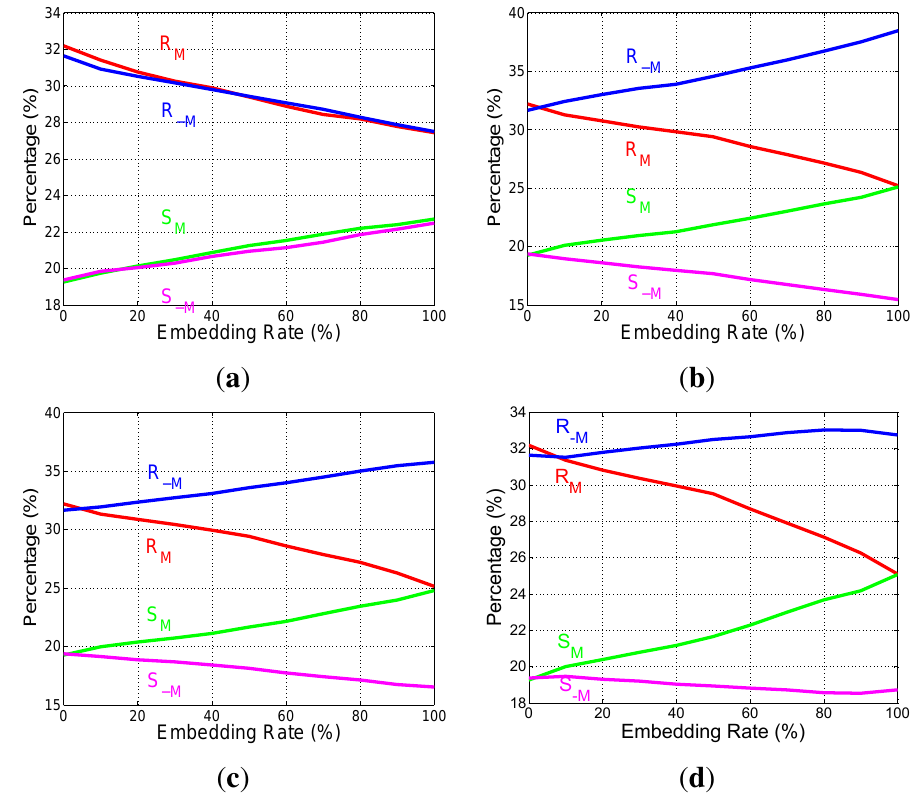
Figure 8. RS steganalysis. ( a ) Proposed scheme; ( b ) 1 -least significant bit (LSB); ( c ) 2 -LSB; ( d ) 3